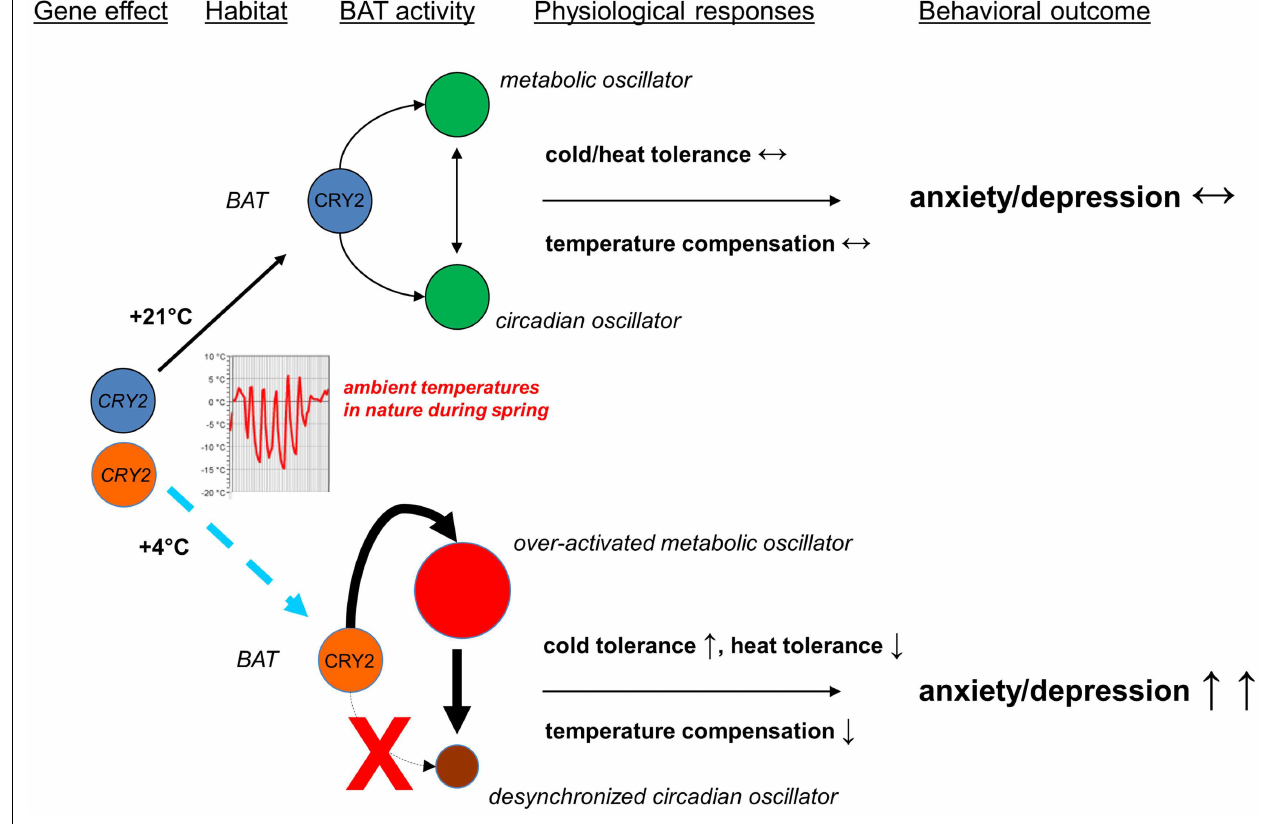
FIGURE 1 | Scheme of the hypothesis integrating the circadian control, brown adipose tissue activity, and mood. Rapid changes in ambient temperature (cold nights, warm days) which are typical at temperate latitudes during the late-spring activate brown adipose tissue, once being activated it will not cool down easily and remains therefore prone to over-activation. Because of a genetic effect ( CRY2 gene mutations or common variants which compromise the function of CRY2 proteins) or abnormalities in the